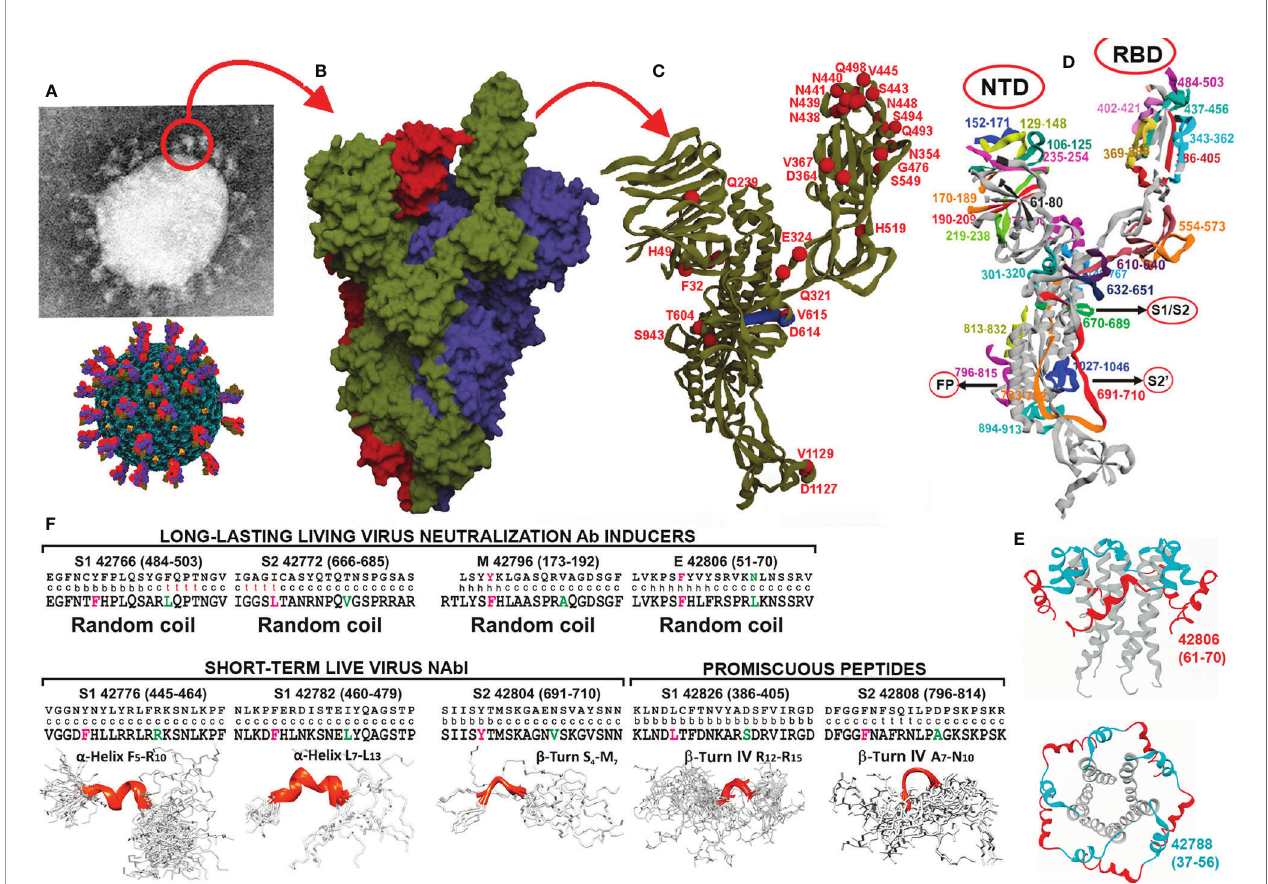
FIGURE 1 | SARS-CoV-2 protein structural features and parental peptide design regarding relevant regions. (A) SARS-CoV-2 EM ‘ corona ’ structure and diagram of the virus. (B) PBD 6X6P-based SARS-CoV-2 trimer protein surface model (protomers in dark green, red, and purple). (C) S protein, protomer backbone structure, with some variable residue aa locations (red balls) and ADE region (dark blue fragment). (D) S protein protomer ribbon structure; colours represent aa regions and location of selected peptides to be modi fi ed for COLSARSPROT development. (E) Viroporin protein E pentamer (code PDB: 5X29) structure, locating selected peptides (side and top views). (F) Parental peptides ’ aa sequence (top) with 3D structure determined by X-ray crystallography in the middle row (c: coil, b: beta strand, t: turn, h: a helix), modi fi ed peptides ’ aa sequence bottom in bold letters and their 3D structure determined by ¹H-NMR, highlighting speci fi c LL-LiViNAbI, ST- LiViNAbI and promiscuous